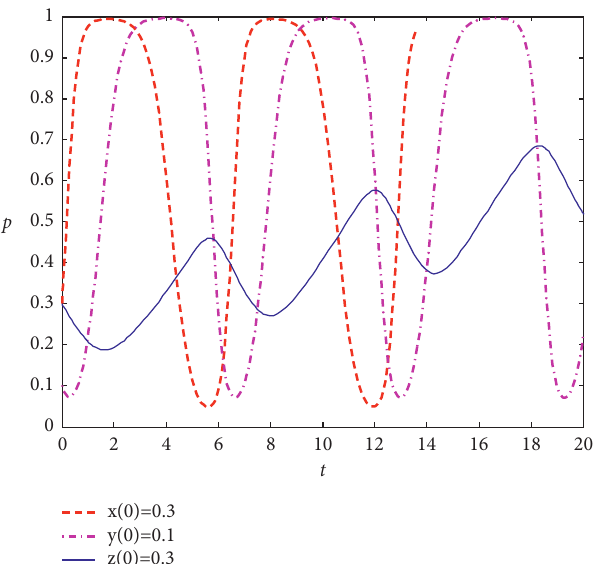
Figure 6: Evolutionary equilibrium results under different initial states.